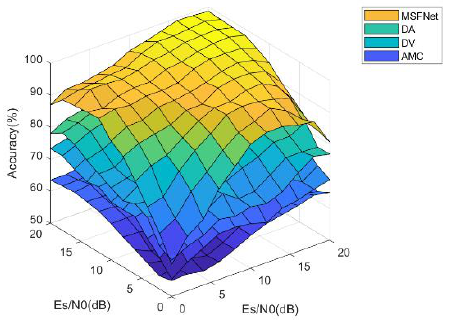
Figure 8. Overall performance comparison of different fusion